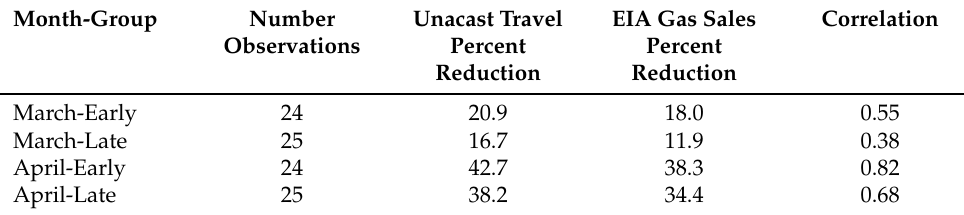
Table A3. Comparison of travel data with gasoline sales